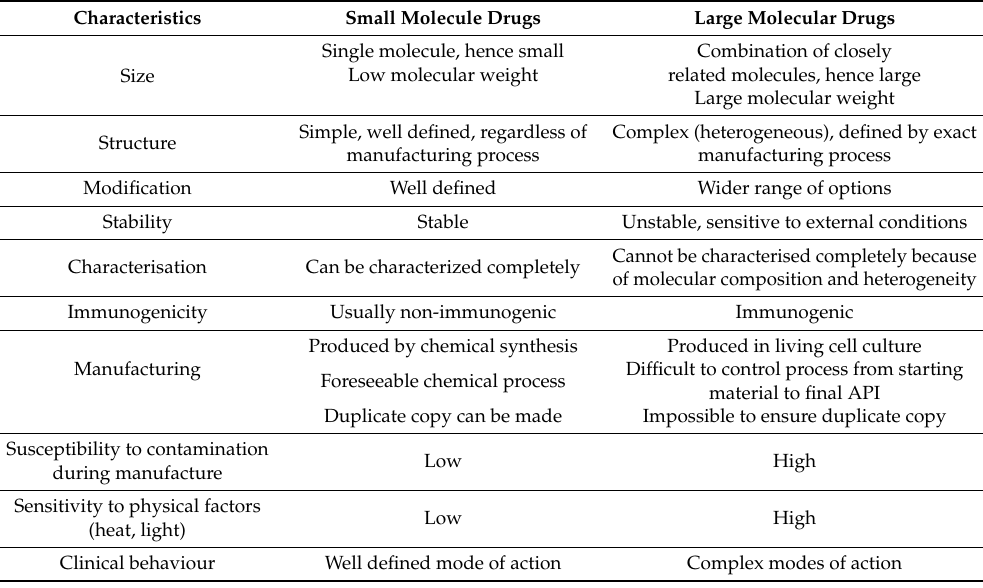
Table A4. Differences between small molecule drugs and biological